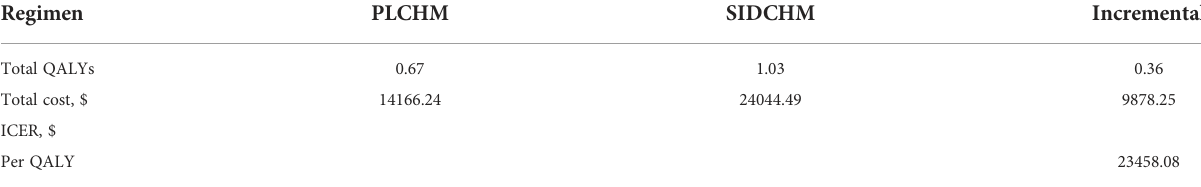
TABLE 3 Effectiveness and costs in the model.